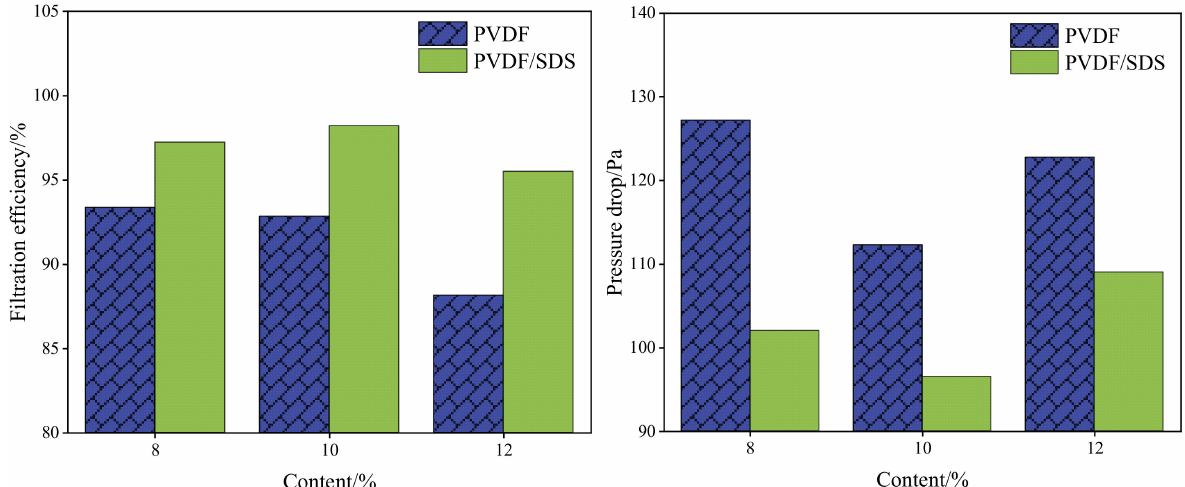
Figure 9. Filtration efficiency and pressure drop of